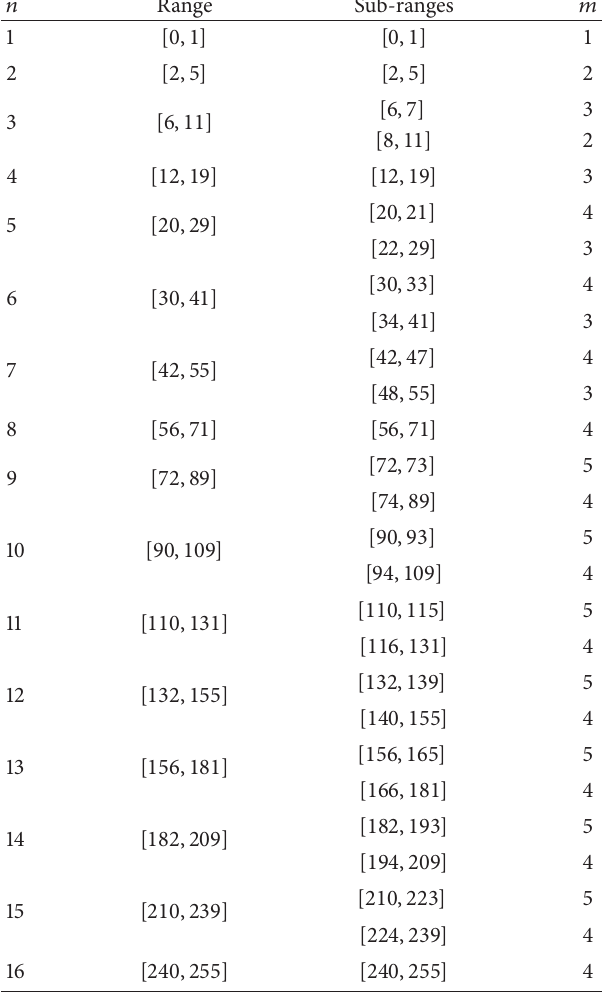
Table 1: The quantization range table based on the perfect square